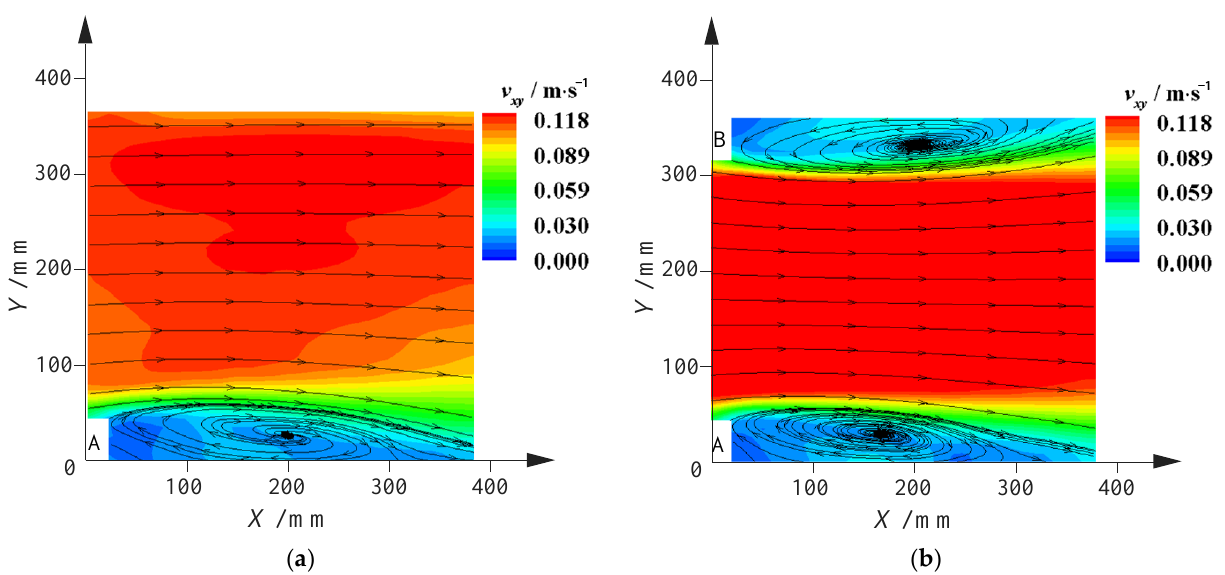
Figure 4. Time-averaged velocity distribution and streamlines of ( a ) a single Groin A and ( b ) two symmetrical Groins A and B: the color indicates the velocity magnitude.